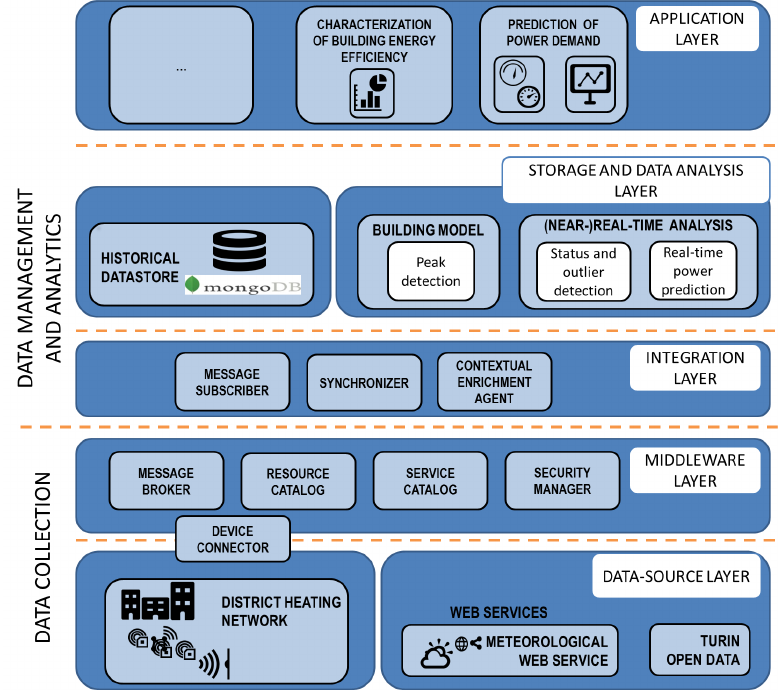
Figure 1. PH I -C I B architectural